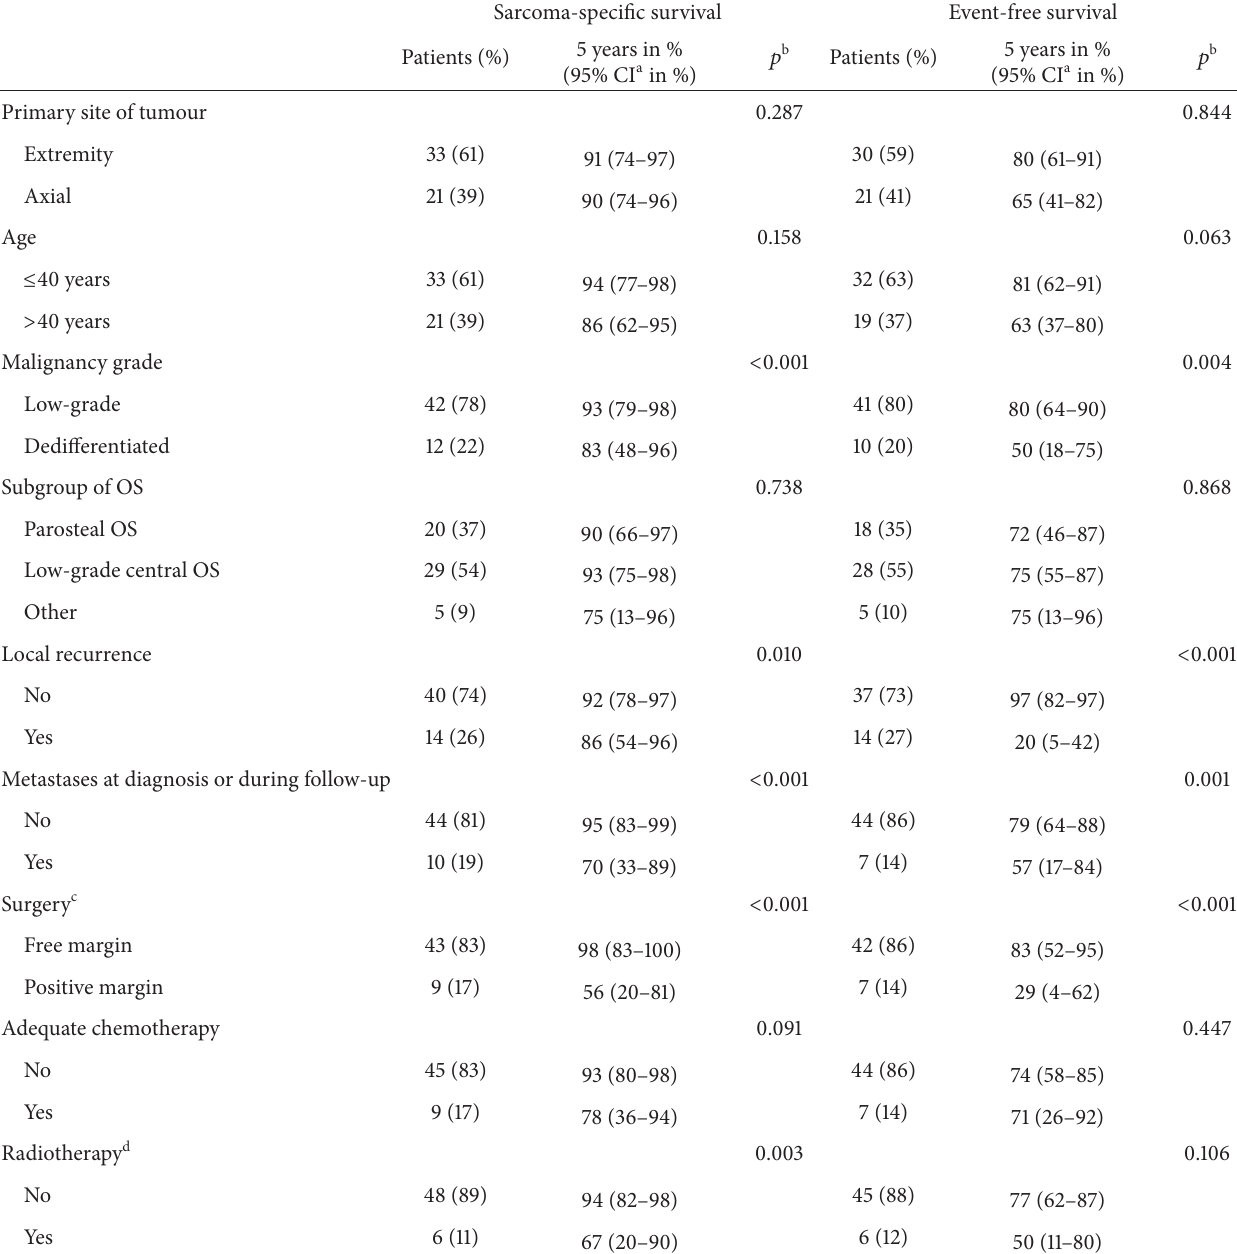
Table 5: Univariate Kaplan-Meier analyses of five-year sarcoma-specific survival and event-free survival according to different characteristics of 54 patients with low-grade or dedifferentiated osteosarcoma